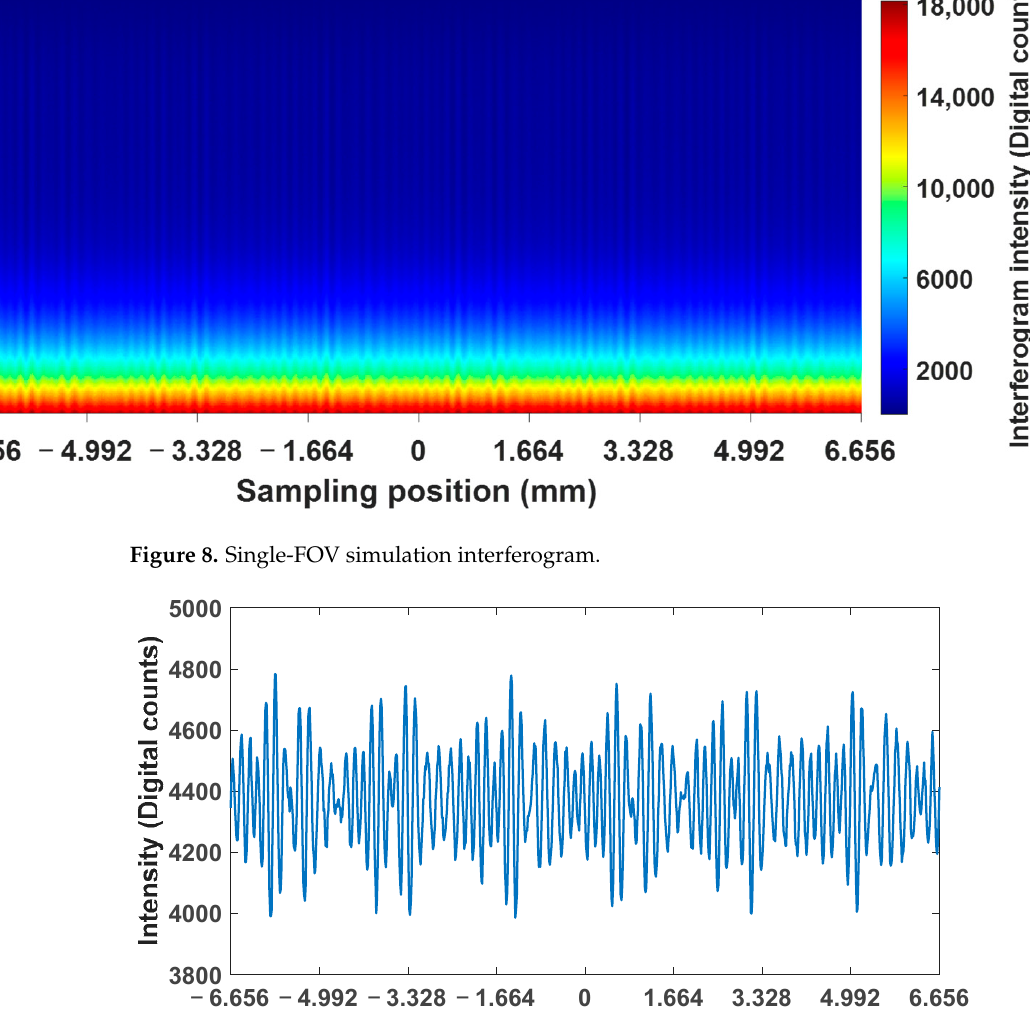
Figure 9. Interference fringes at the tangent altitude of 60 km. Figure 10 gives the results of the three quantitative evaluation indexes. The signal- to-noise ratio (SNR) reflects the overall signal and its corresponding noise intensity level.